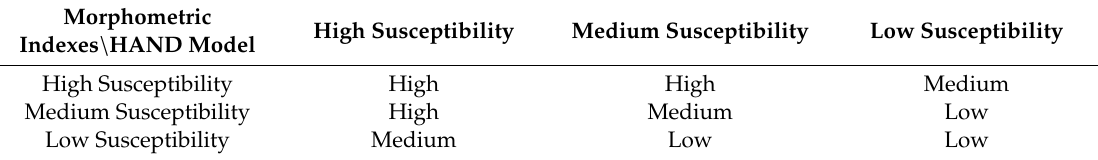
Table 1. Correlation matrix between Morphometric Indexes and Height Above Nearest Drainage (HAND) Model